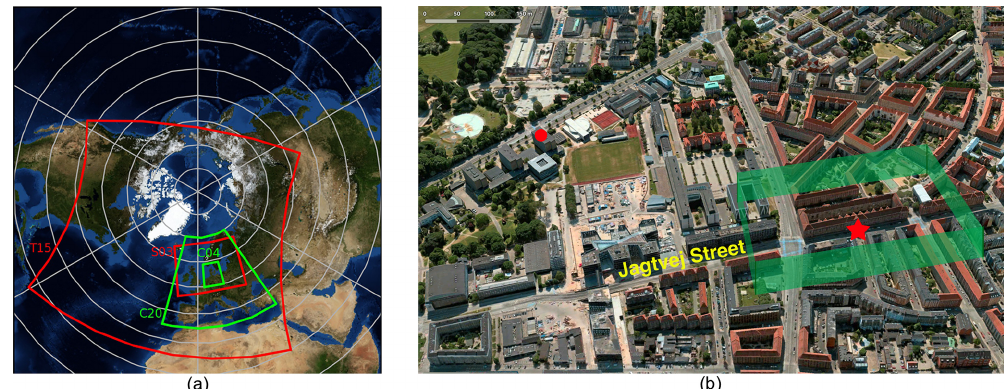
Figure 1. (a) Operational and research modeling domains for European regional scale (HIRLAM-T15 + CAMx-C20) and subregional-urban Denmark scale (HIRLAM-S03 + CAMx-C04) forecasts; (b) Nørrebro district of Copenhagen urban area with two air-quality monitoring stations, where the red circle indicates a roof level air quality observation at H. C. Ørsted Institute and the red star indicates Jagtvej Street level observation; the green trapezoid shows the M2UE modeling domain (extracted from © Apple Maps